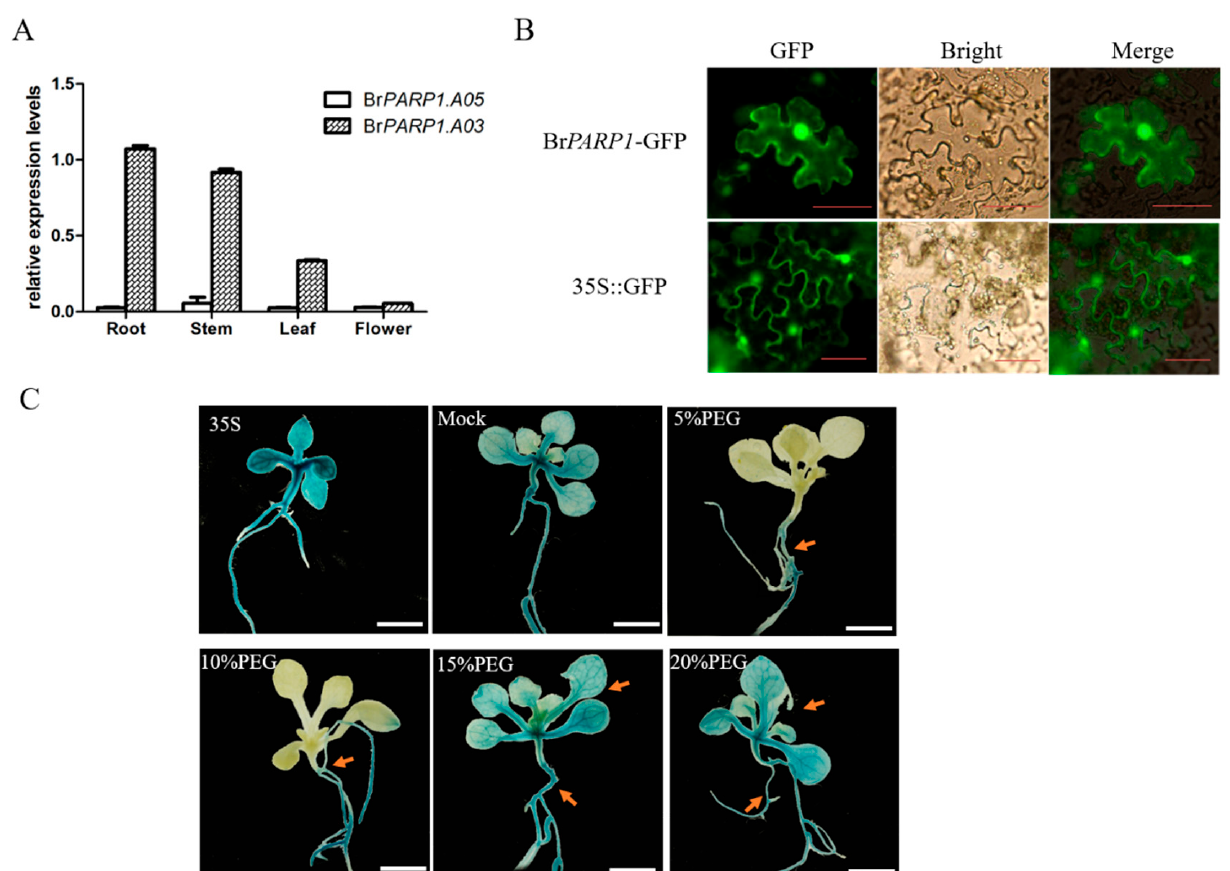
Figure 2. The expression of Br PARP1 and subcellular location. ( A ) Analysis of Br PARP1 for tissue-specific expression. The Actin gene was used as a reference. ( B ) Subcellular localization of the fused 35S::Br PARP1 -GFP in N. benthamiana leaf cells. The 35S::GFP construct as the control. Bar = 50 μ m. ( C ) Histochemical staining in transgenic A. thaliana plants. GUS stains analysis proCaMV35S::GUS transgenic A. thaliana plants. GUS stains analysis proBr PARP1 ::GUS transgenic A. thaliana plants after 0%, 5%, 10%, 15%, and 20% PEG6000 treatment. Bar = 5 mm.